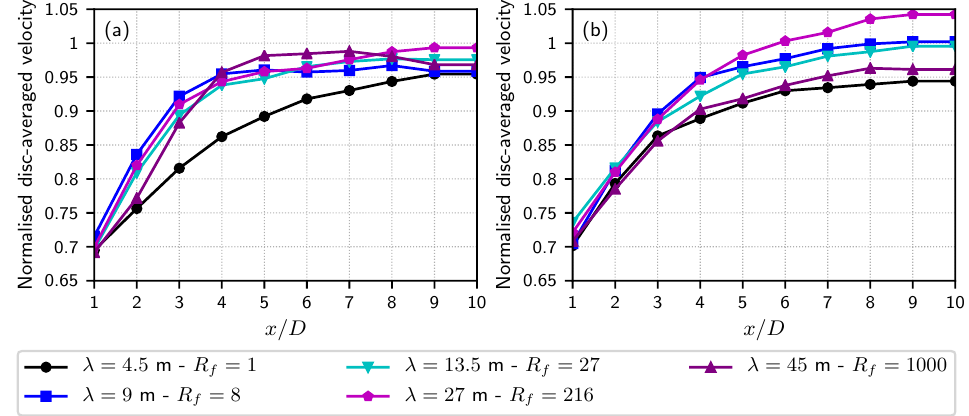
Figure 9. Comparison of the numerical disc-averaged velocities obtained for TSR = 4.1, I ∞ = 10% and several λ . ( a ) σ ( λ ) = 0%. ( b ) σ ( λ ) =